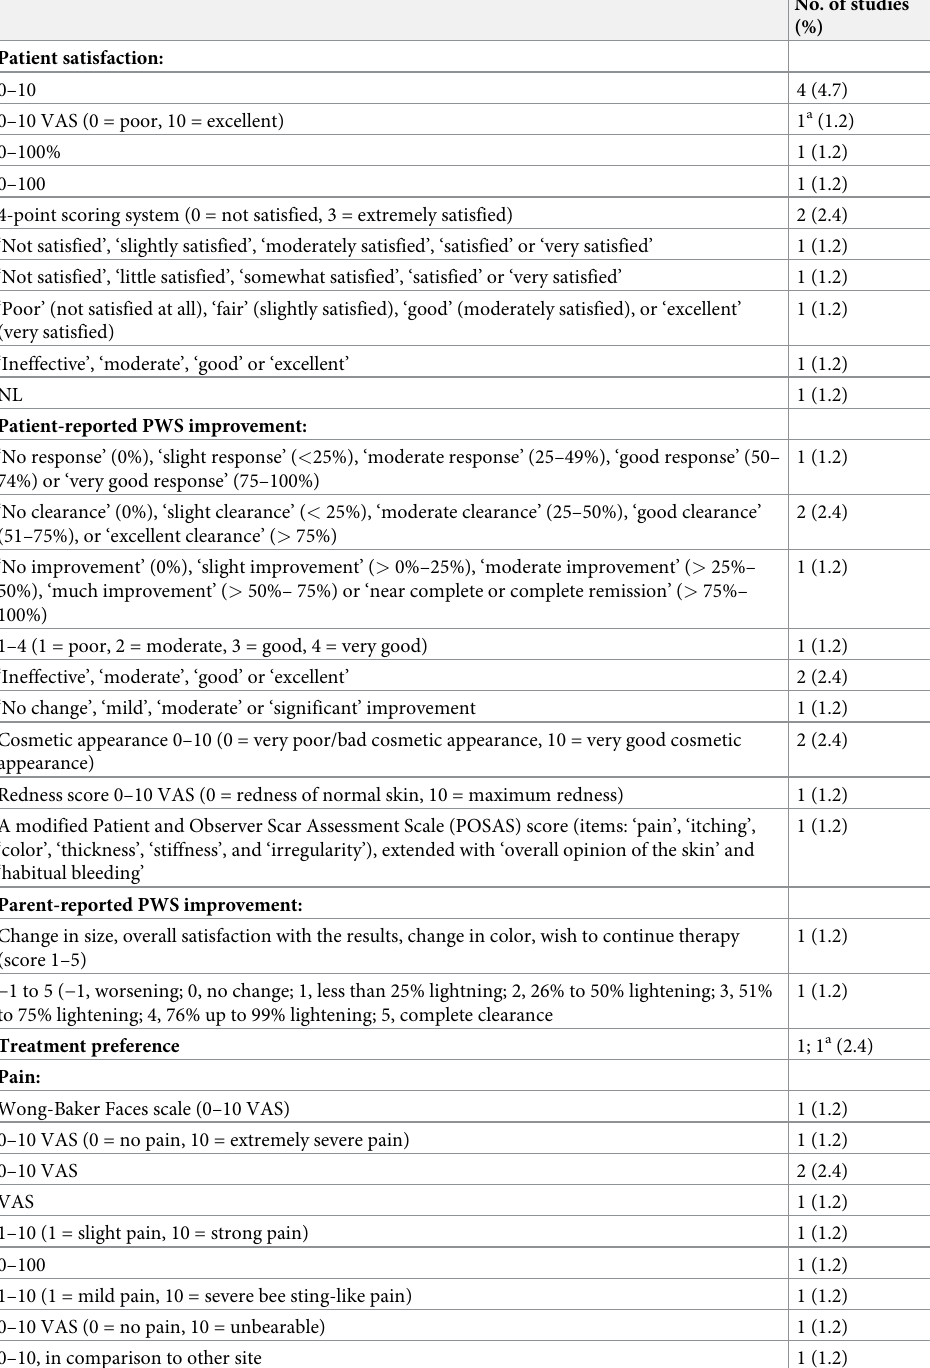
Table 2. Patient- and parent-reported outcome measures and scoring systems in prospective trials from 2005 to May